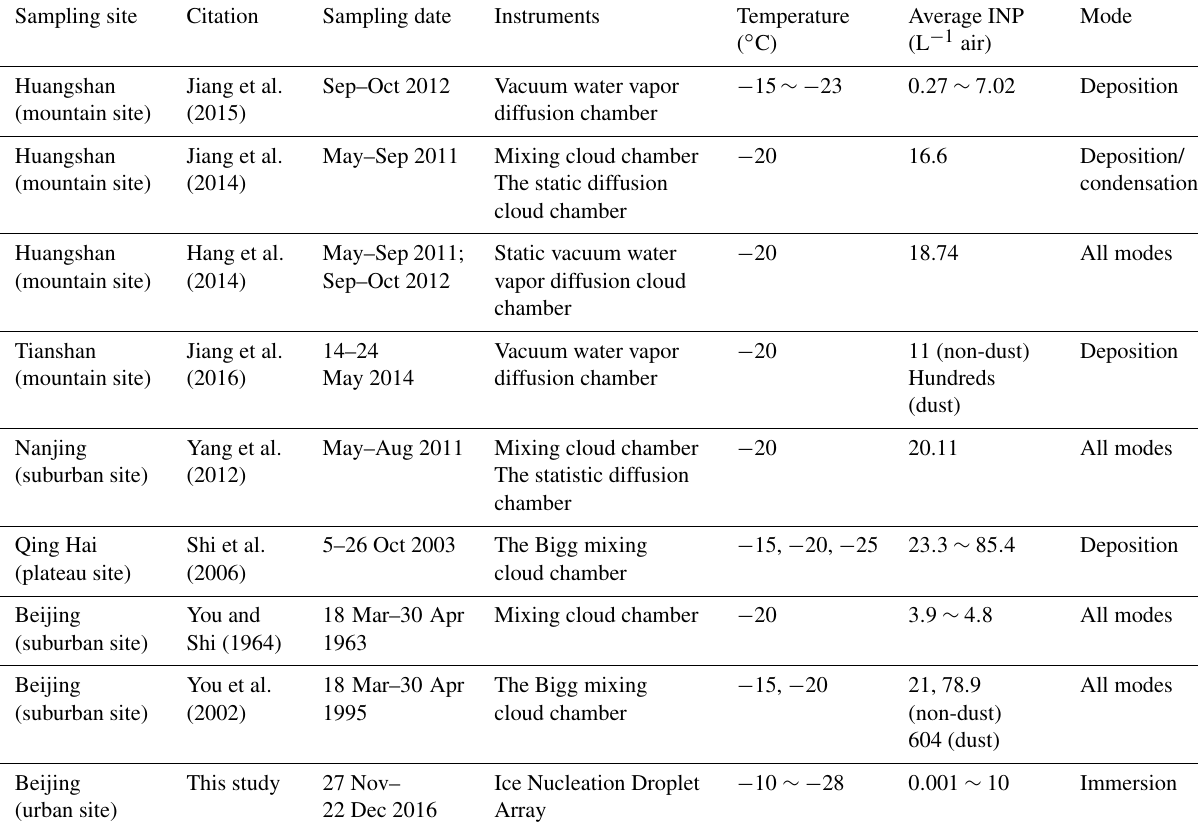
Table 2. Comparison of INP measurements in different regions of China, including N INP (i.e., INP number concentrations) and corresponding